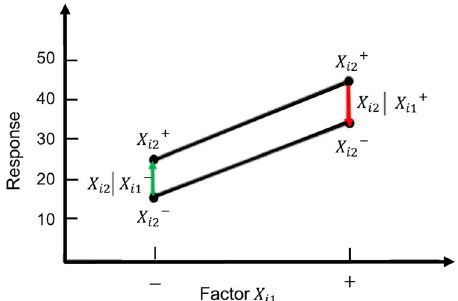
Fig. 9 Interaction plot of an input factor X i on the X-axis and the 1 response variable on the Y -axis. Another input factor X i is varied 2 simultaneously to produce two lines corresponding to the low and high levels of X i 2 order statistics from the standard normal distribution, to yield their respective cumulative probabilities and corre- sponding z -test statistics according to